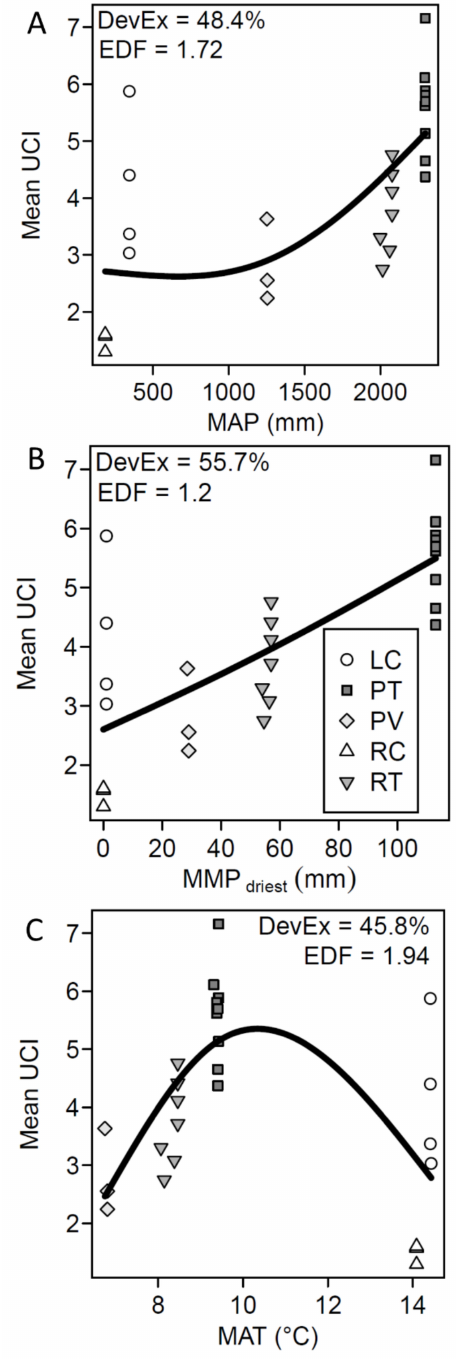
Figure 10. ( A ) Relationship between understory layer complexity assessed using the UCI and mean annual precipitation (MAP), ( B ) mean precipitation during the driest month of the year (MMP), and ( C ) mean annual temperature MAT). EDF = effective degrees of freedom. Bold lines: visualizations of the fitted GAM models. LC = Parque Nacional la Campana, PT = Parque Tan- tauco, PV = Parque Nacional Villarica, RC = Reserva Nacional las Chinchillas, RT = Reserva San Pablo de